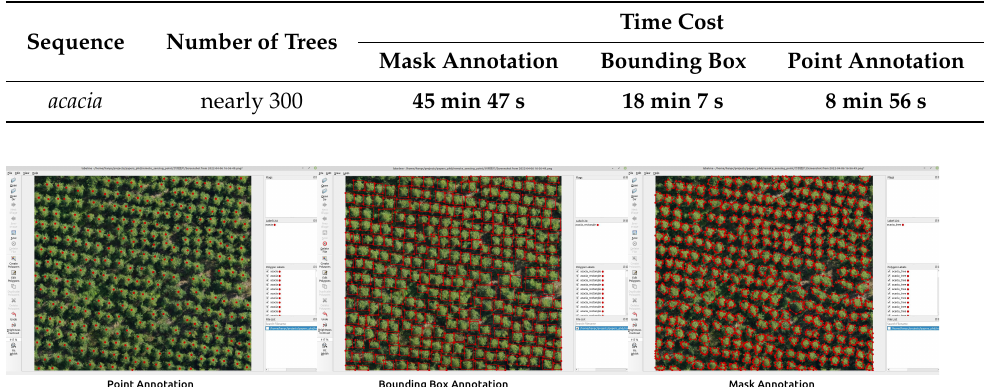
Table 6. The annotation time cost under different annotation ways including point, bounding box, and mask annotation.